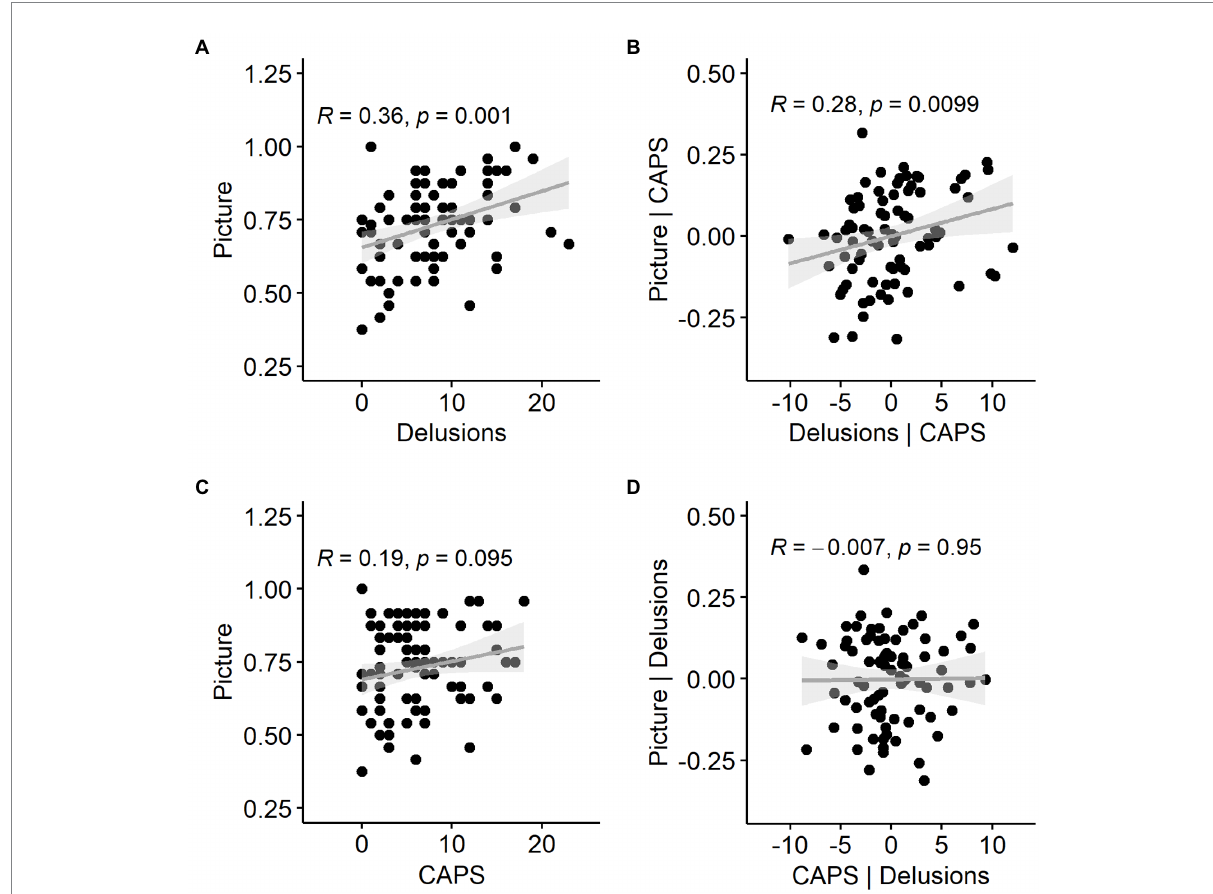
FIGURE 7 Relationship between pareidolia proneness in the Picture Pareidolia task, tendency for delusional ideation and abnormal perceptual experiences (hallucinations). (A) Scatter plot of the delusion score and Picture Pareidolia hit rate with a regression line and Spearman’s correlation coefficient. (B) same as (A) , but with hallucination-related variance as measured by the CAPS questionnaire removed. (C) Relationship between pareidolia proneness and hallucinations as measured by CAPS. (D) Same as (C) , but with delusion-related variance